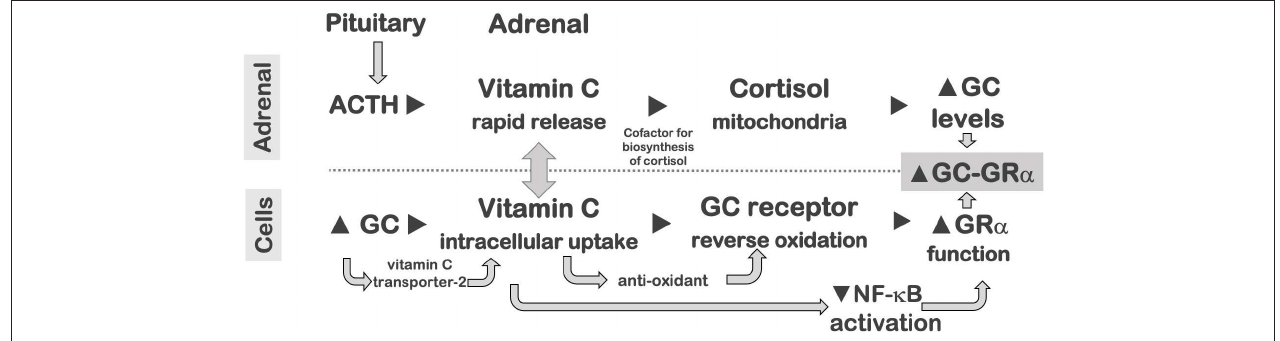
FIGURE 6 | Impact of vitamin C on activated GR α activity. (Top) Adrenal: The adrenal and pituitary glands have very high concentrations of ascorbic acid (vitamin C). In response to ACTH release from the corticotrophs of the anterior pituitary gland, the adrenal gland rapidly secretes ascorbic acid, an essential cofactor required for adrenal steroidogenesis in mitochondria, contributing to increased glucocorticoids synthesis. (Bottom) Cells: glucocorticoids, in a time- and concentration-dependent manner, increase the expression of mSVCT2, facilitating the uptake of ascorbic acid into the cell. Ascorbic acid reverses oxidation of the GR, restoring cellular glucocorticoid-responsiveness in oxidant conditions. In addition, ascorbic acid inhibits TNF α - and IL-1 β -induced activation of NF- κ B in a dose-dependent manner by inhibiting phosphorylation and degradation of I κ B α . These combined actions result in increased glucocorticoid availability and GC-GR α activation and improved homeostatic